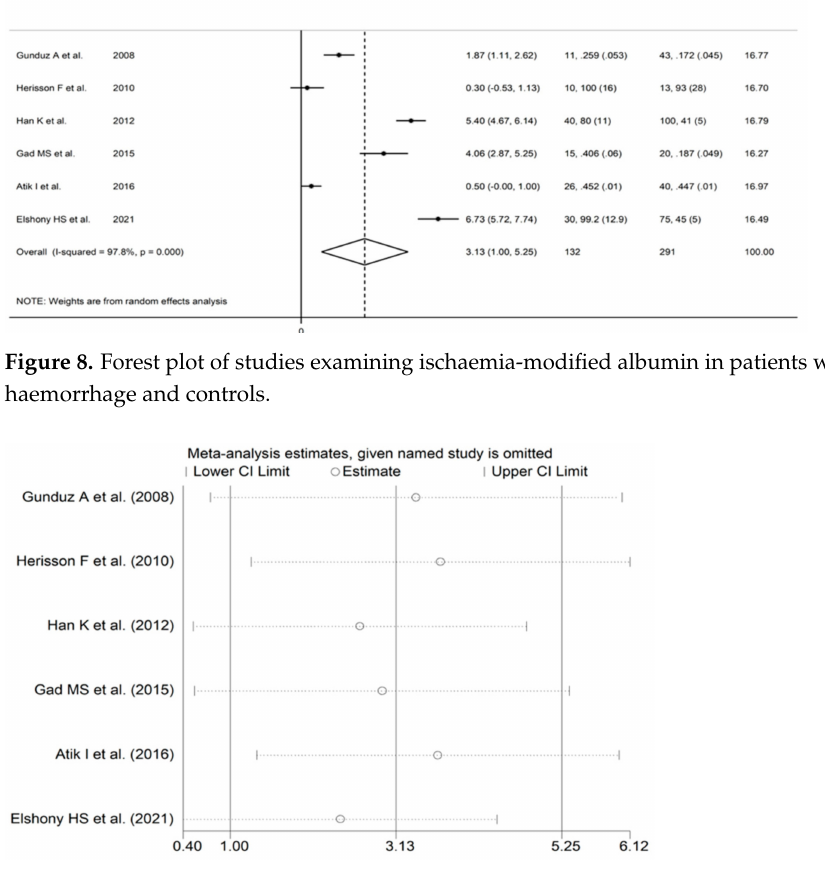
Figure 9. Sensitivity analysis of the association between serum ischaemia-modified albumin and intracerebral haemorrhage. For each study, the displayed effect size (hollow circles) corresponds to an overall effect calculated from a meta-analysis excluding that study.